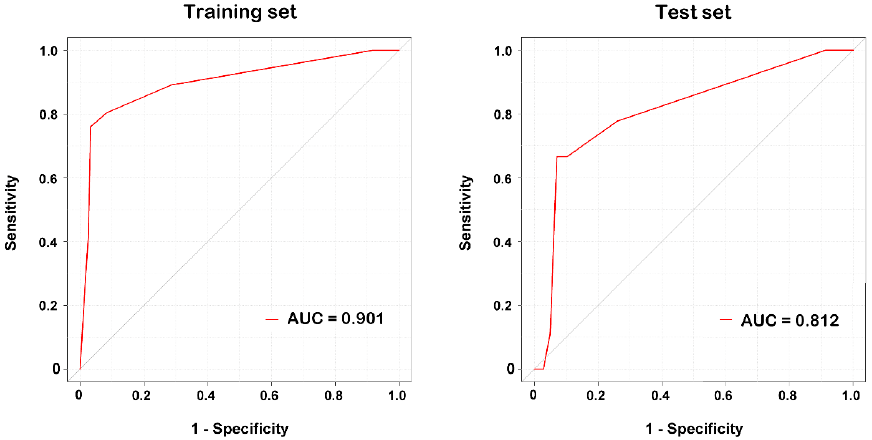
Figure 2. Illustration of ROC curves for the DT model in the training and test set.